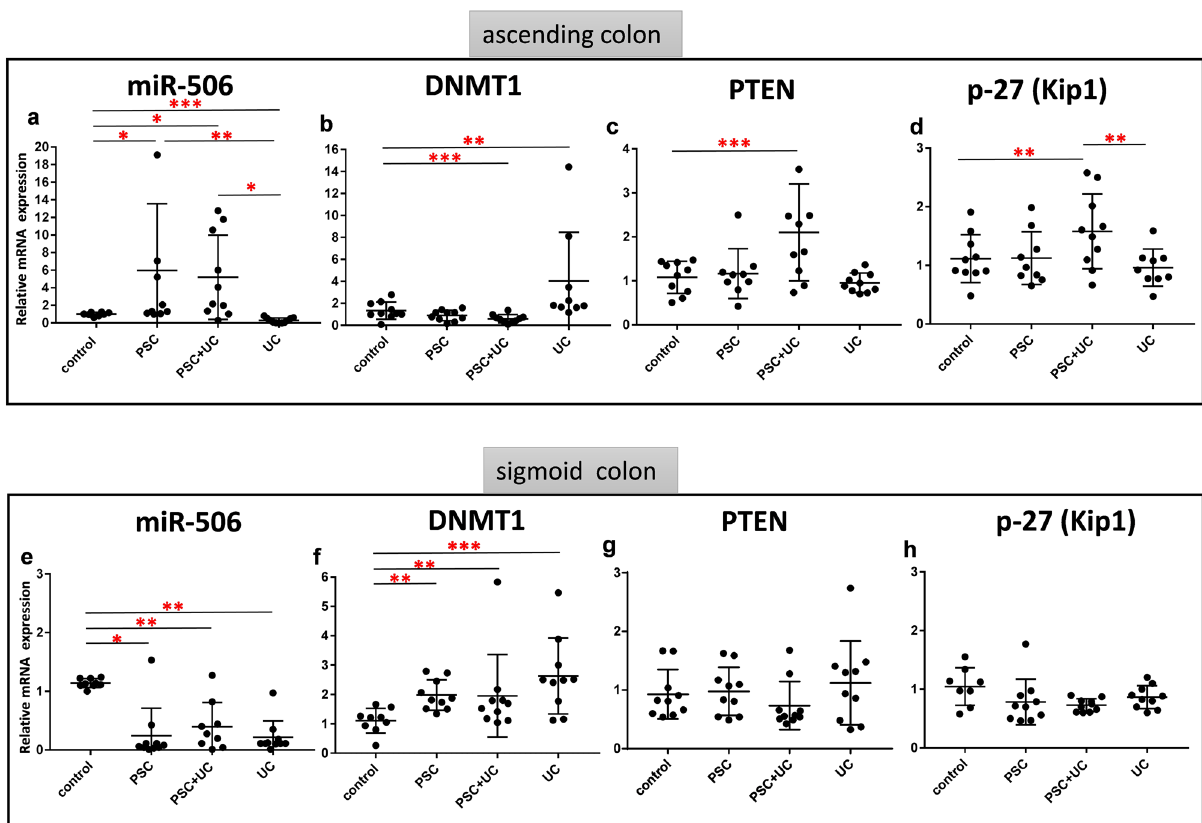
Figure 1. Expression of microRNA-506 (miR-506), DNA-methyltransferase-1 (DNMT1), phosphatase and tensin homolog (PTEN), and p27(Kip1) mRNAs in large intestines of the patients. Relative expression levels of miR-506 (a,d) , DNMT1 (b,e) , PTEN (c,f) , p27Kip1 (d,g) in ascending (a–d) and sigmoid colons (e–h) of controls (n = 10), PSC (n = 10), PSC + UC (n = 10), and UC (n = 10). The expression of all genes are normalized to an endogenous reference (miR-191 for miR-506, or 18S rRNA for other genes) and presented as a relative fold change to controls according to the comparative Ct method (2 −ΔΔCt. ). Dots illustrate each patient and lines the mean plus interquartile range (IQR). Statistics: one-way ANOVA followed by Fisher’s PLSD test within the groups; *indicates p-value < 0.05, ** p-value p < 0.01, *** p-value < 0.001.